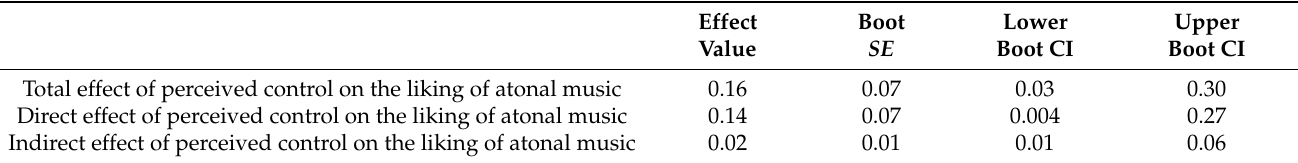
Figure 1. Mediation model of the need for structure in the relationship between perceived control and liking of atonal music. Path values are the path coefficients with standard errors. * p < 0.05. ** p < 0.01. Table 2. Mediating effect test of the need for structure.